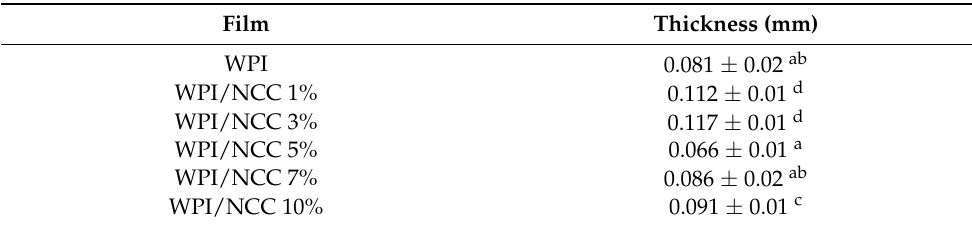
Table 2. Thicknesses data of whey protein film combined with nanocrystalline cellulose.